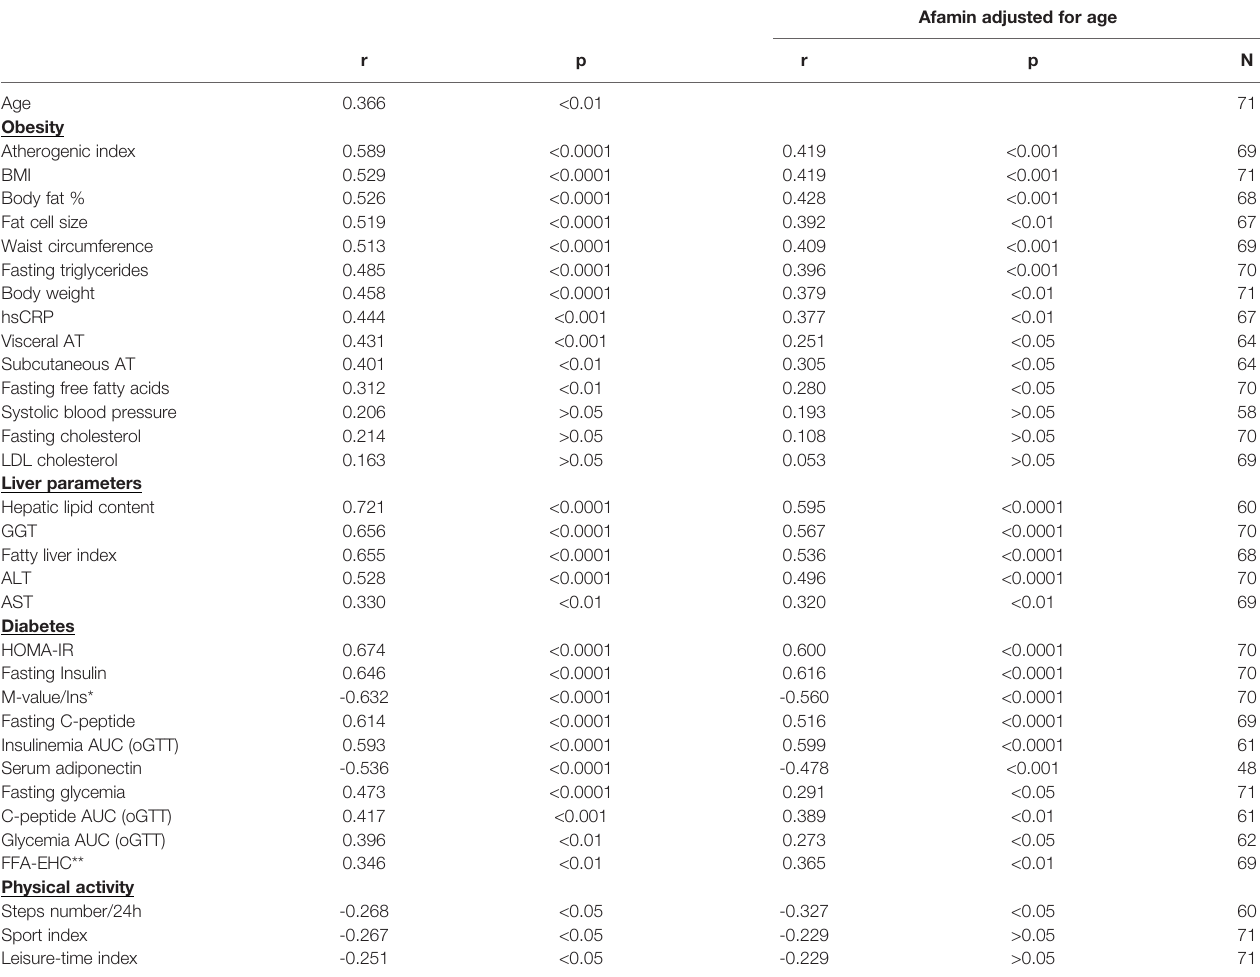
TABLE 2 | Afamin correlates with parameters of obesity, insulin resistance & physical